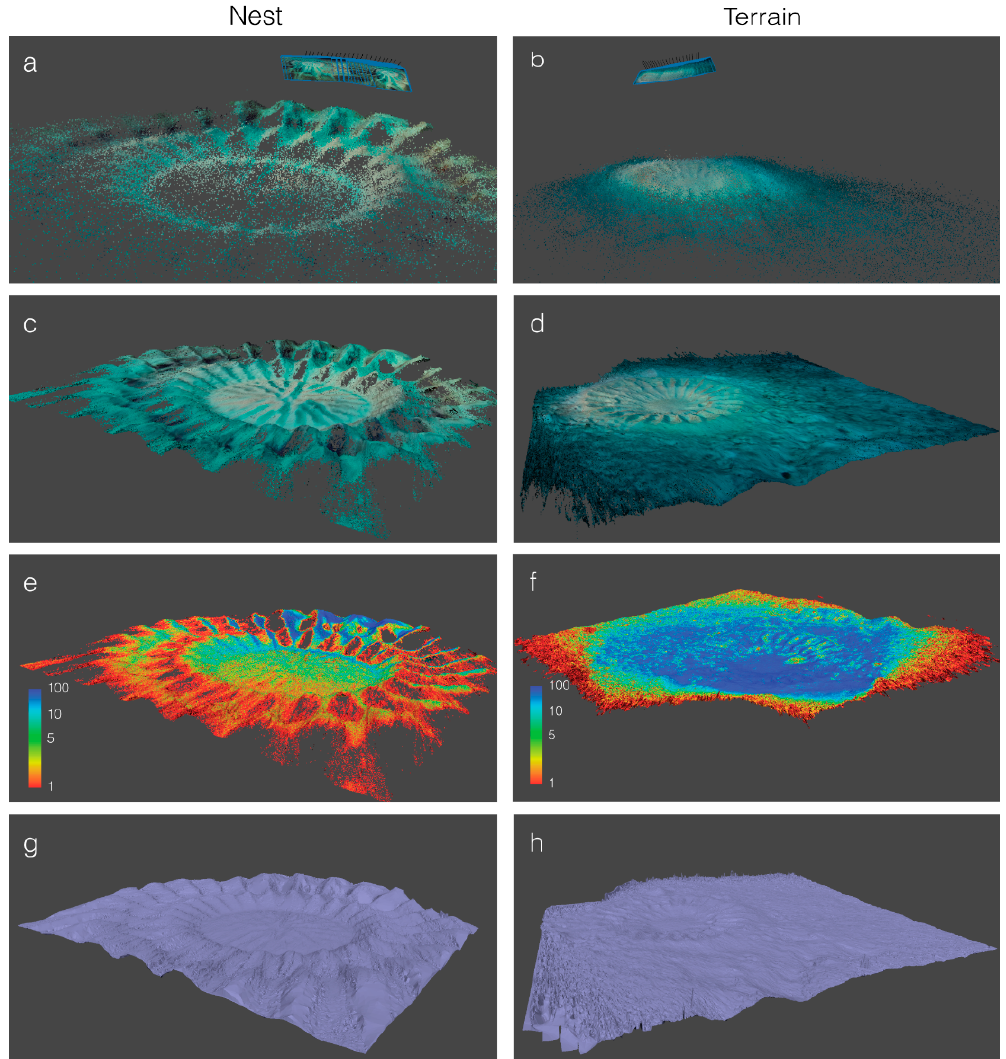
Figure 4. Nest and terrain reconstruction workflow outputs. ( a , b ) visualisation of the sparse point cloud and calculated camera orientations. ( a ) clearly shows lack of tie points at the edge of first peak and central zone due to the area being "blind" to the camera. Likewise, a–b shows dispersion of tie points with increasing distance from the cameras; ( c , d ) dense point cloud computed from the sparse point cloud and camera depth maps; ( e , f ) dense cloud point confidence can be used to identify areas of low confidence and high noise. These can be manually removed to improve reconstruction; ( g , h ) polygonal models built from the dense cloud